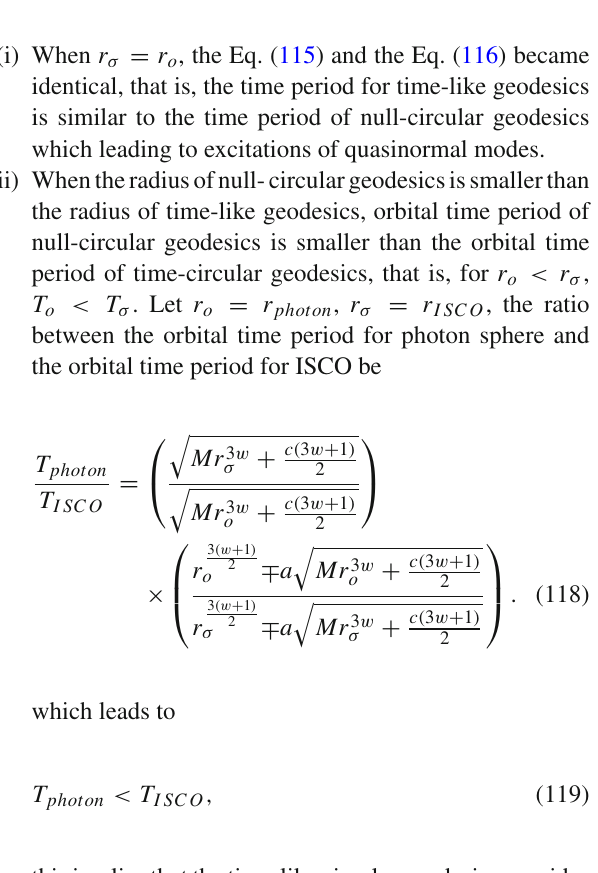
Fig. 4 The plot shows the orbital angular frequency (cid:9) Versus a for differentvaluesofradius r intherange r o ≤ r ≤ r σ ,where r σ and r o are theradiusoftime-likegeodesicandnull-circulargeodesic,respectively. Green (solid) color indicates for the value where the radius of time-like and null-circular geodesics are coincide, Red(Dashed) color indicates for the value of radius of null-circular geodesic and blue (Dot-Dashed) color indicates the value of radius of time-like geodesic. We use units such that M = 1 , c = 2